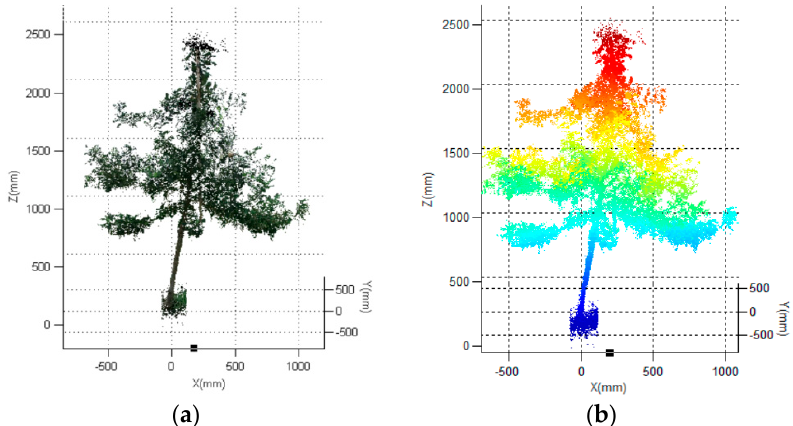
Figure 7. Model of the fruit tree 3D point cloud after precise registration via iterative closest point (ICP): ( a ) 3D point cloud of fruit tree after ICP (image with original color); ( b ) 3D point cloud of fruit tree after ICP (image with coloration).